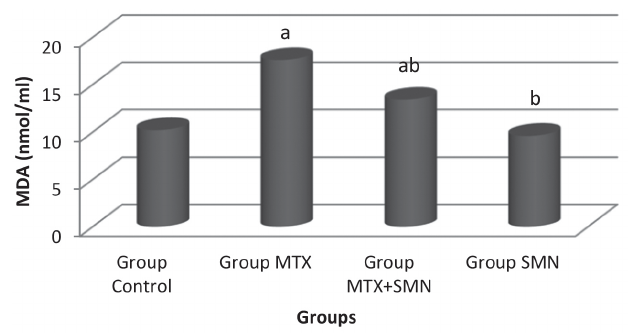
FIGURE 4 - Effects of MTX and SMN on MDA levels in testis tissue of rats.